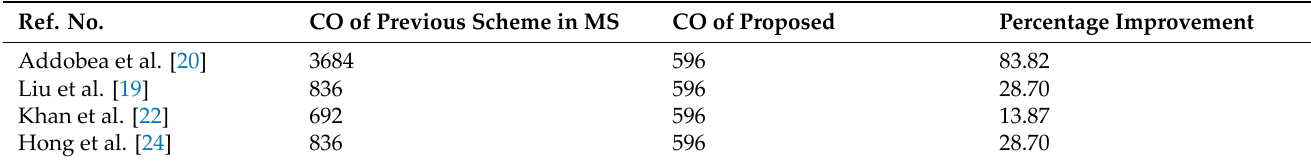
Table 9. Communication overhead improvement.